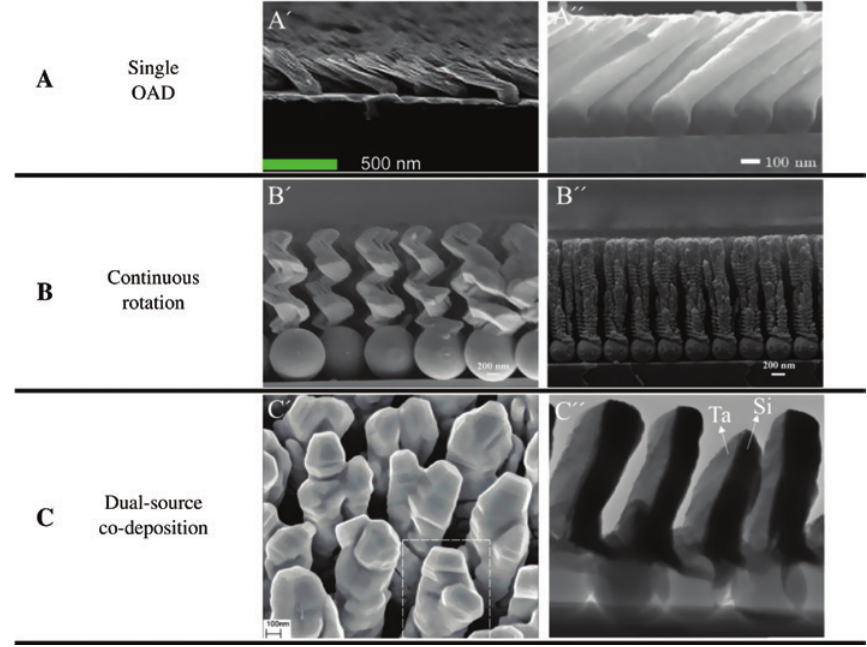
Figure 4: Representative examples of nanorods on CCs. (A) Cross-section SEM images of tilted nanorods fabricated on spheres by a single OAD. (A ′ ) Tilted Pt nanorods fabricated at θ = 85 ° [42]. (A ″ ) Tilted CoPt nanorods fabricated at θ = 87 ° [43]. (B) Cross-section SEM images of nanorods fabricated by GLAD with continuous rotation [67]. (B ′ ) Si spirals on a Si substrate covered with 830-nm colloid particles. (B ″ ) Multilayer Si spiral/column rods on a Si substrate covered with 490-nm colloid particles. (C) Nanorods fabricated by dual-source co-deposition. (C ′ ) SEM images of Y-shaped Cu nanorods [44]. (C ″ ) Cross- sectional TEM micrograph from an array of Si-Ta two component nanorods grown on silica spheres [45].